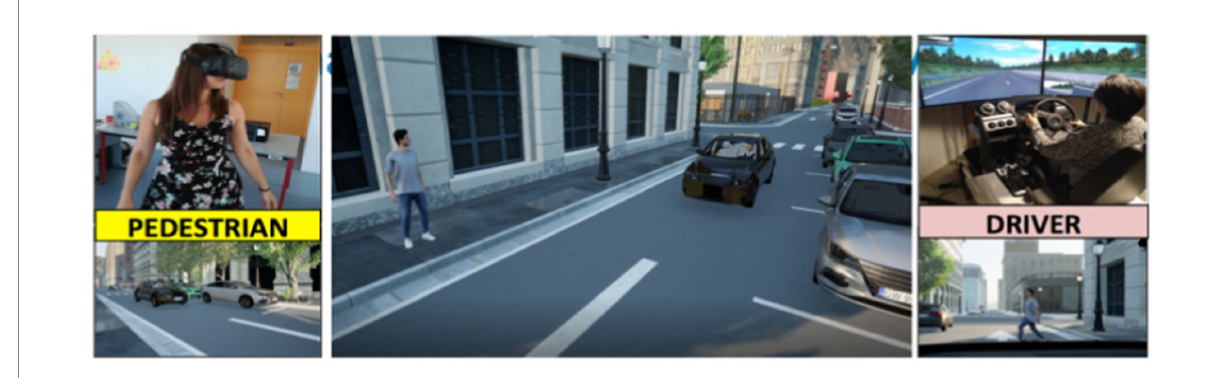
FIGURE 1 Pedestrian and automated vehicle scenario of